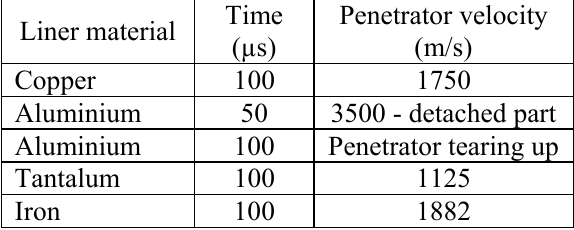
Figure 17. Velocity and shape of iron made penetrator (Autodyn); after 100 µs [8] Penetrator velocities are presented in Table 3. Table 3. Comparison of penetrator velocities made of different materials